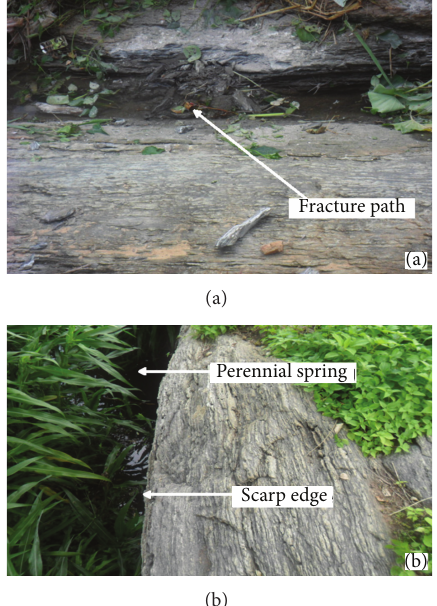
Figure 2: Surface manifestations of the Uneme-Nekhua fracture zone: (a) dry fracture/stream path before the onset of considerable rains and (b) rock scarp with perennial spring from which locals derive water in the dry season.